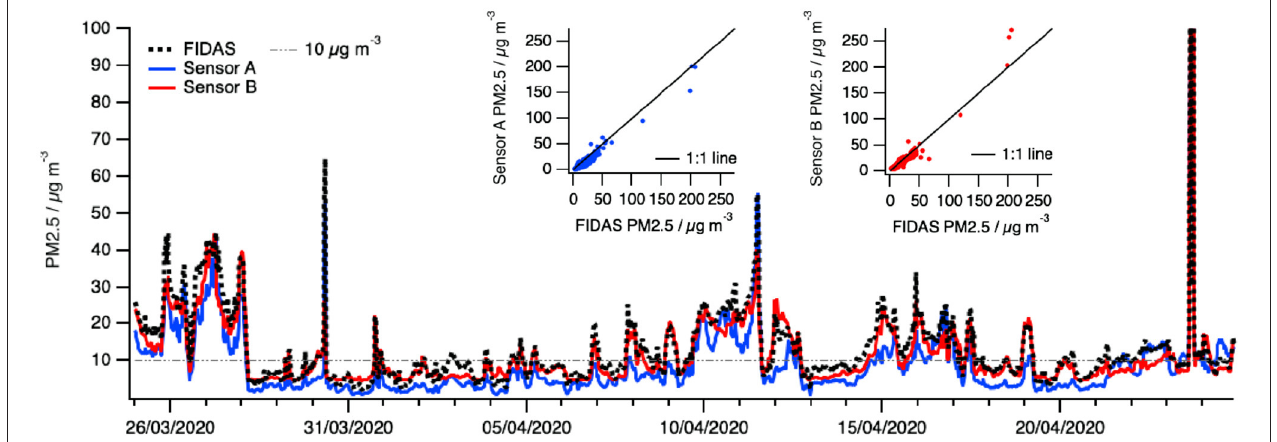
FIGURE 1 | Time series of PM2.5 measurements made at the Manchester NERC supersite by a FIDAS reference equivalent method (black dashed) and two low-cost sensor devices (red and blue). Correlation plots between the sensors and the FIDAS are shown in inset plots. Grey dashed line indicates the WHO recommended PM2.5 limit value of 10 ug m − 3